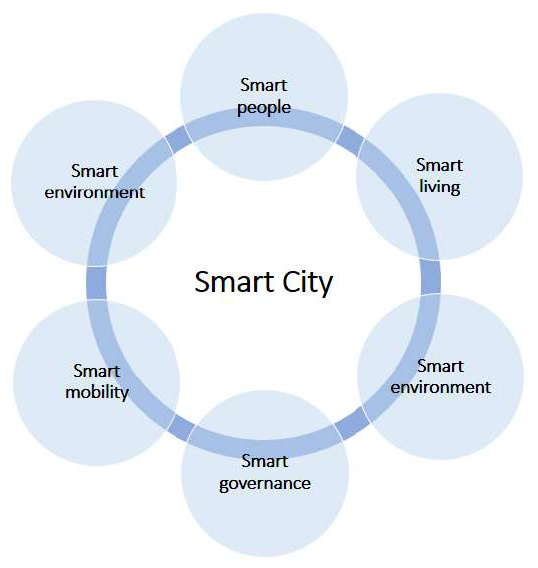
Figure 1. Smart city domains.